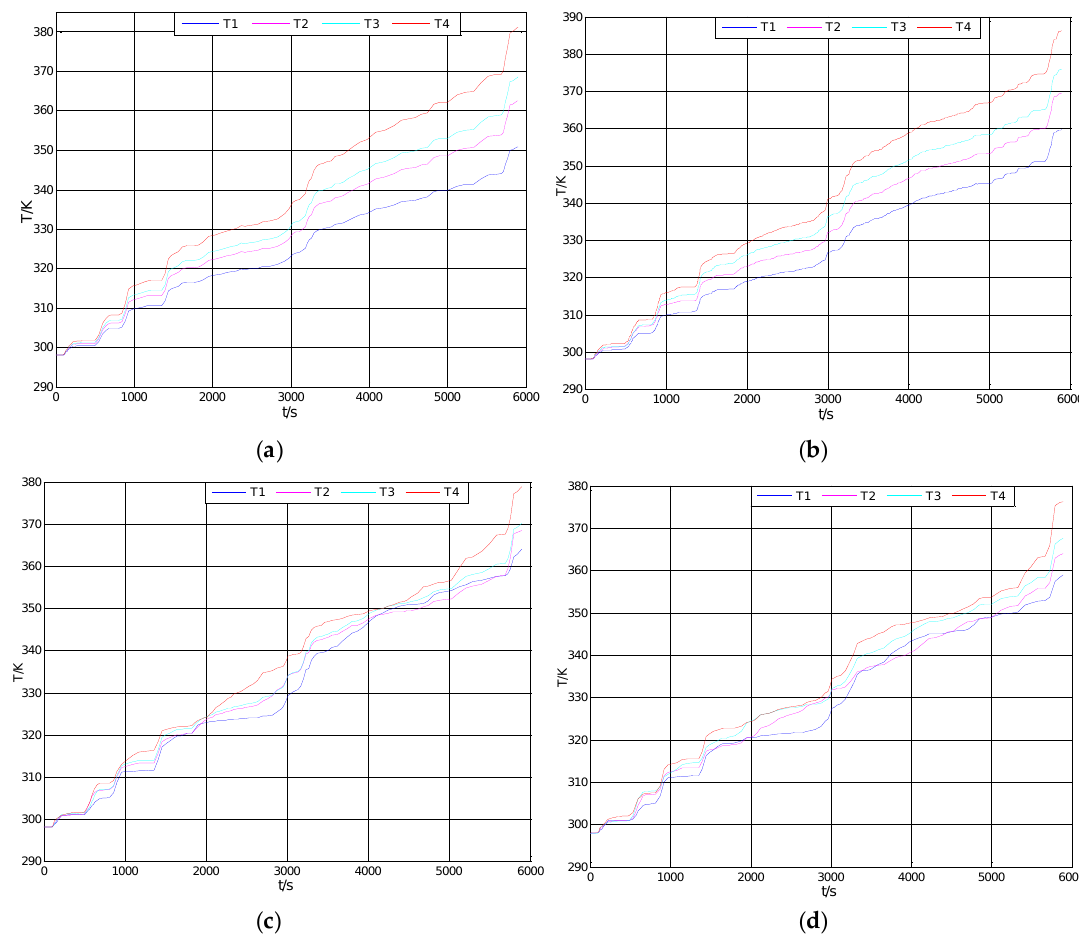
Figure 5. The results of the degradation rate under different balancing control conditions. ( a ) Non- balancing control; ( b ) SOC balancing control; ( c ) Multi-objective balancing control; ( d ) MOPBC. Figure 6a–d are the simulation results of temperature under conditions of non-balancing, SOC balancing, multi-objective balancing and MOPBC, respectively.